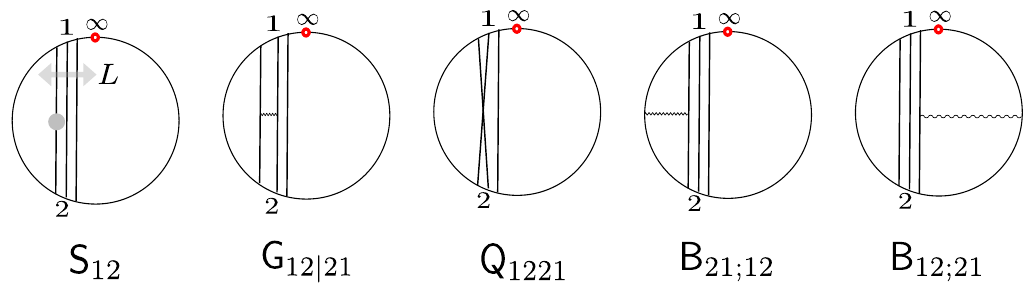
Figure 7 . The one-loop corrections to the two-point functions. Most of the diagrams cancel out owing to (2.25), and the (cid:12)nal result is given by